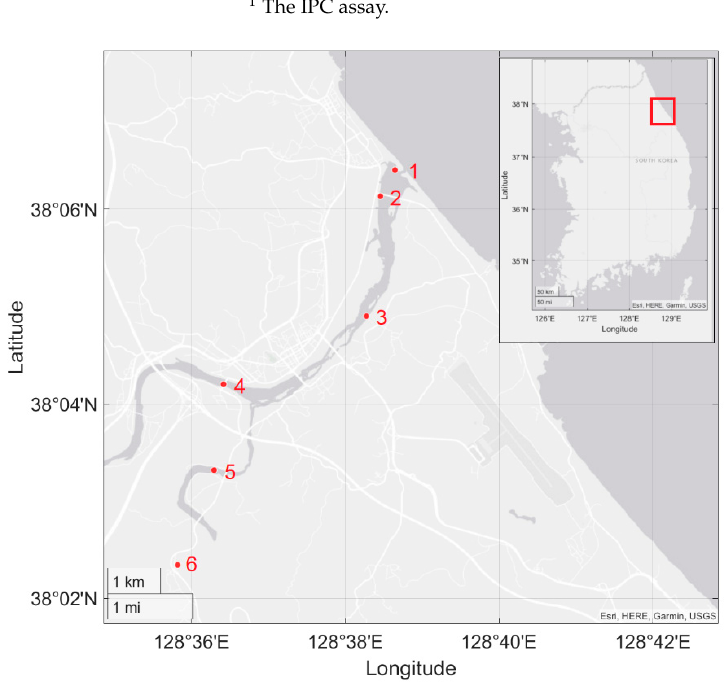
Figure 1. Six study sites in the Yangyangnamdae River, South Korea. Two tributaries, Hucheon and Namdae, were included.